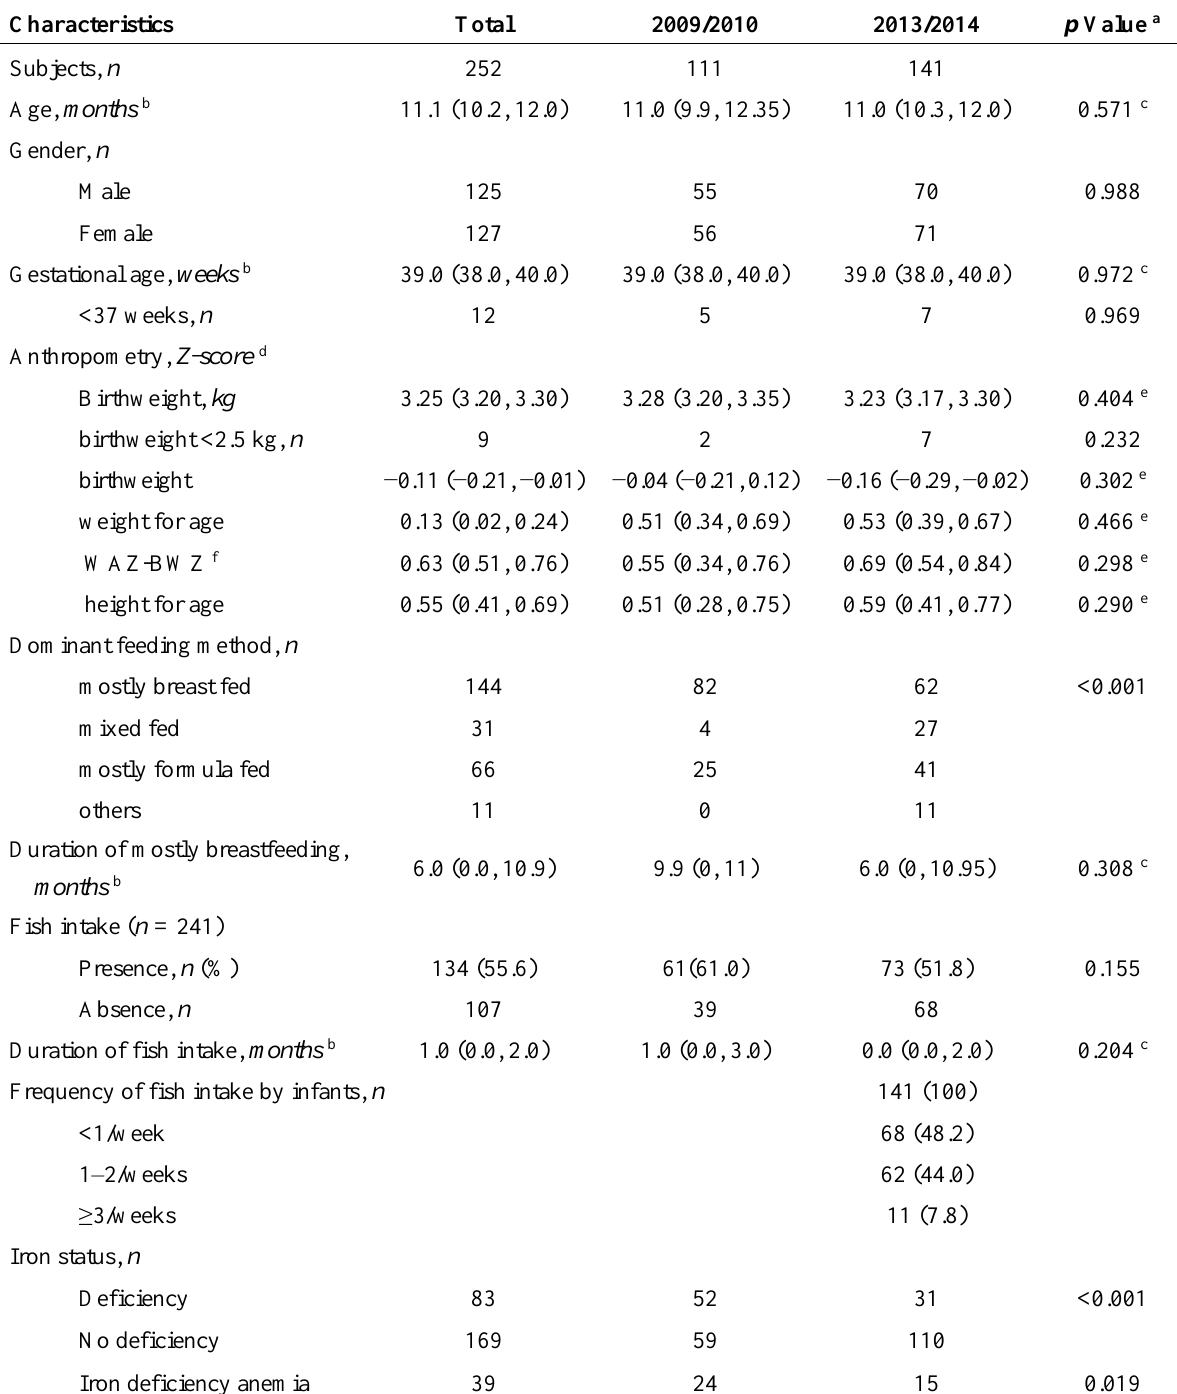
Table 1. Demographic, anthropometric, and diet-related parameters and iron status of 252 infants according to the study